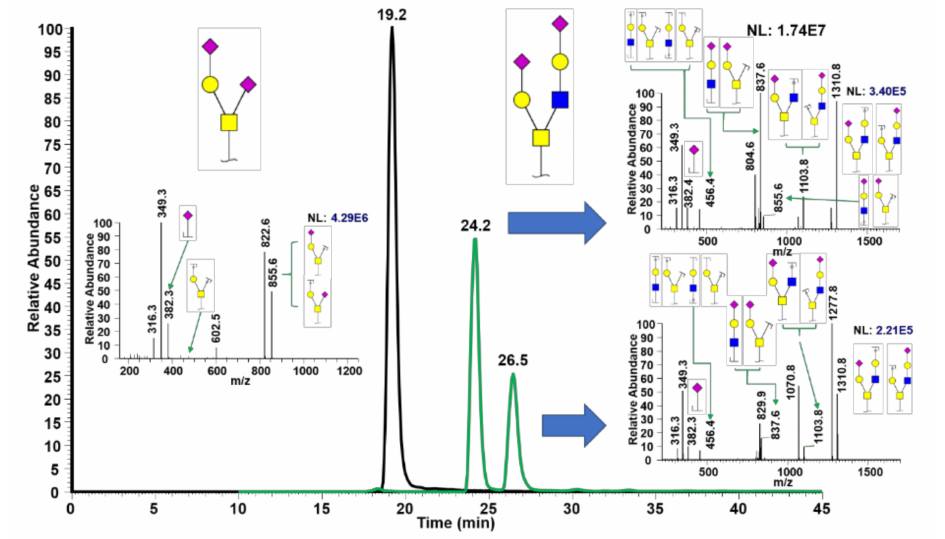
Figure 2. Chromatogram depicting two of the permethylated O -glycans derived from bovine fetuin using PGC-LC-MS. Insets are MS2 spectra for the corresponding peaks.